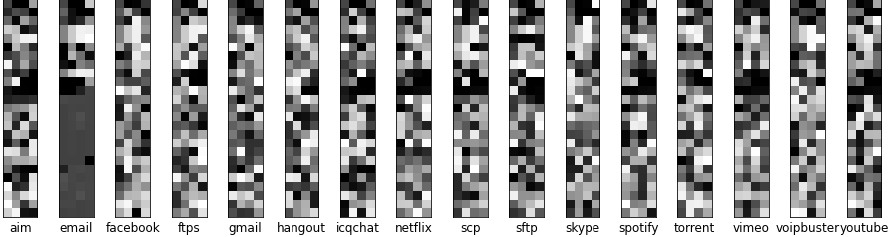
Figure 3. Packet-to-vector images used for packet classification: 16 application images in 100 bytes with payload (ISCXVPN2016 dataset).